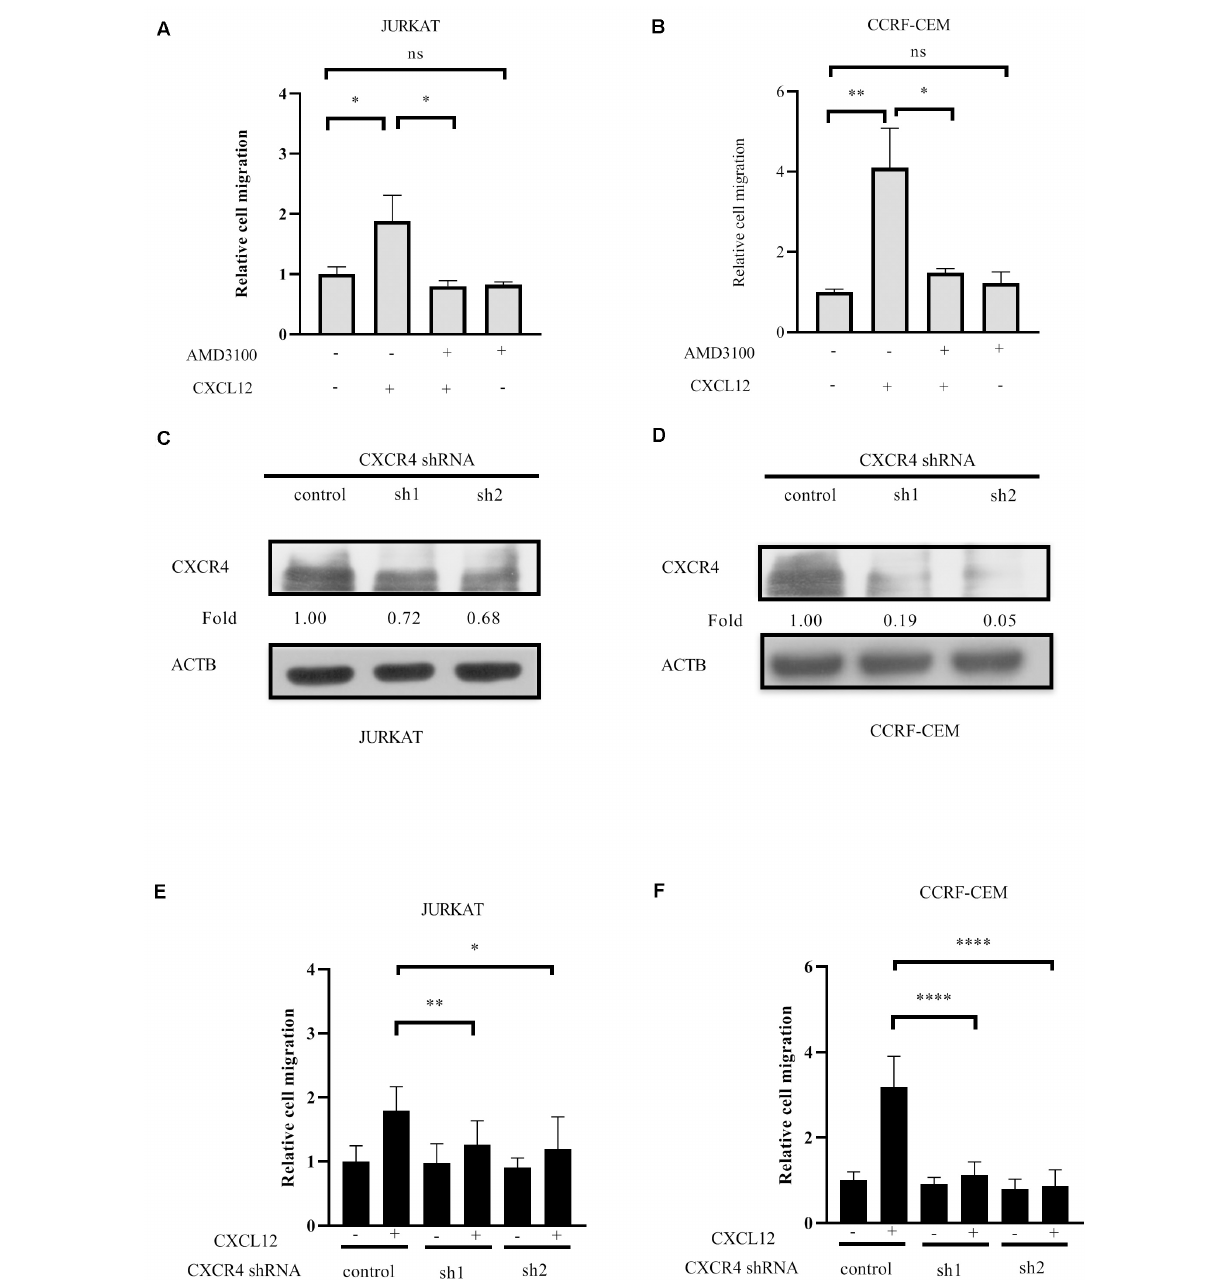
Frontiers in Oncology |